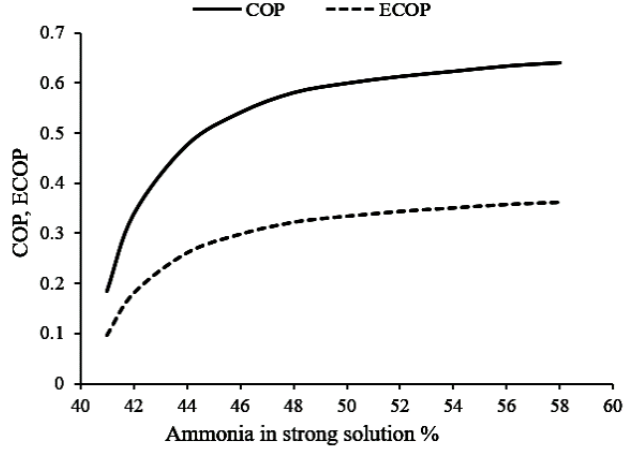
Figure 3. Effect of X ss on energetic and exergetic coefficients of performance (COP and ECOP).